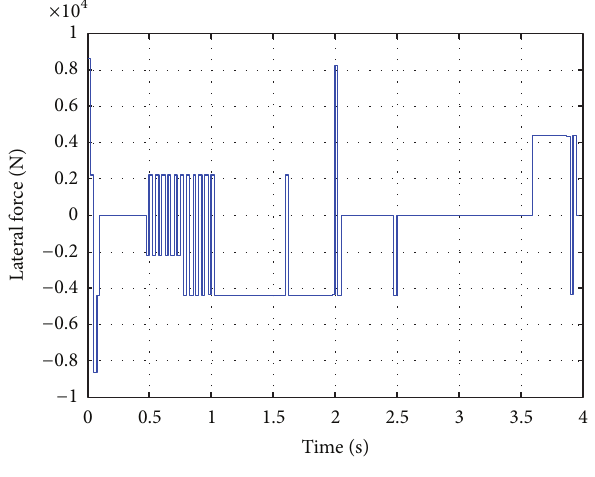
Figure 15: The response of lateral